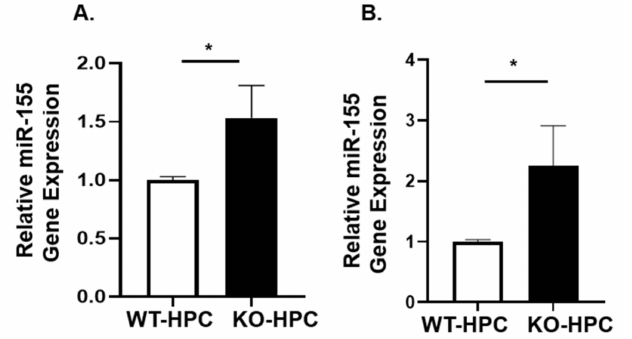
Figure 6. miR-155 gene expression is increased in the BM and Tumor of SHIP KO -HPC mice. Relative quantification of miR-155 gene expression in the ( A ) BM and ( B ) tumors from SHIP WT -HPC and SHIP KO -HPC mice. Data are presented as the mean ± S.D. SHIP KO -HPC ( n = 3) and SHIP WT -HPC ( n = 3) mice. * p < 0.05 (by two-tailed t